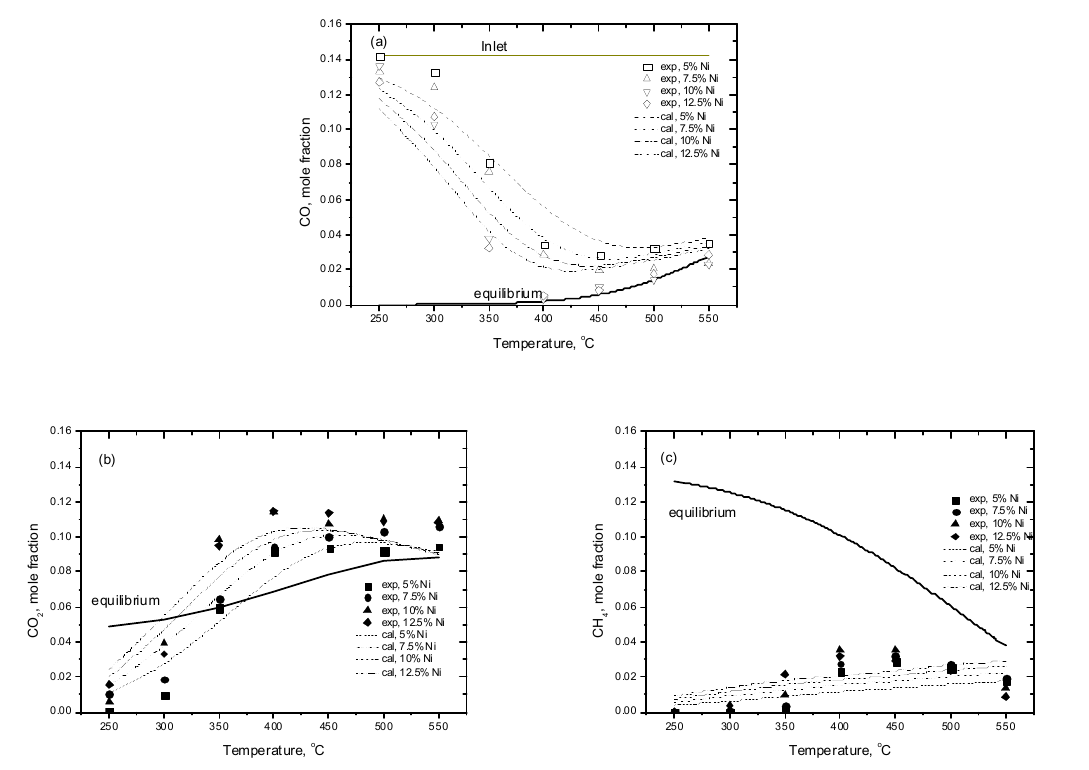
Figure 14. Correlation curves (thick black lines) between CO ( a ), CO 2 ( b ), and CH 4 ( c ) concentrations at 400 °C and the reference contact time calculated as a function of the catalyst loading.